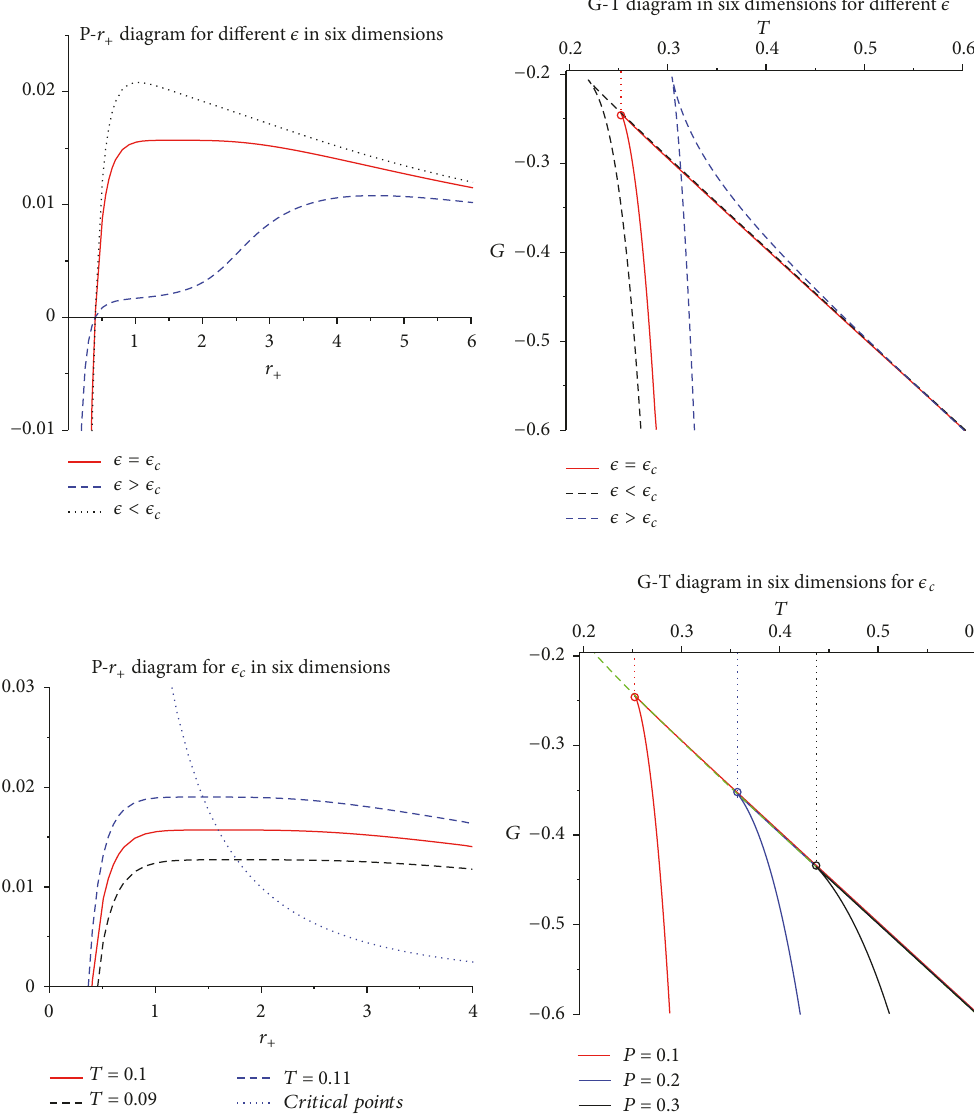
Figure 4: Curves of 𝑃−𝑟 + and 𝐺−𝑇 in six dimensions for different 𝜖 and 𝜖 = 𝜖 𝑐 . There is no 𝑃−𝑟 + oscillatory behavior and phase transition.